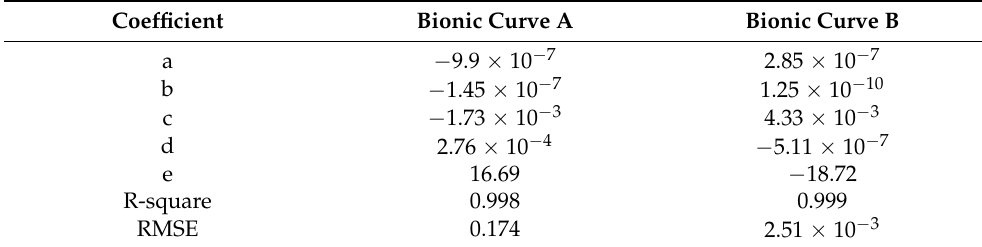
Table 1. Bionic curve fitting parameters.